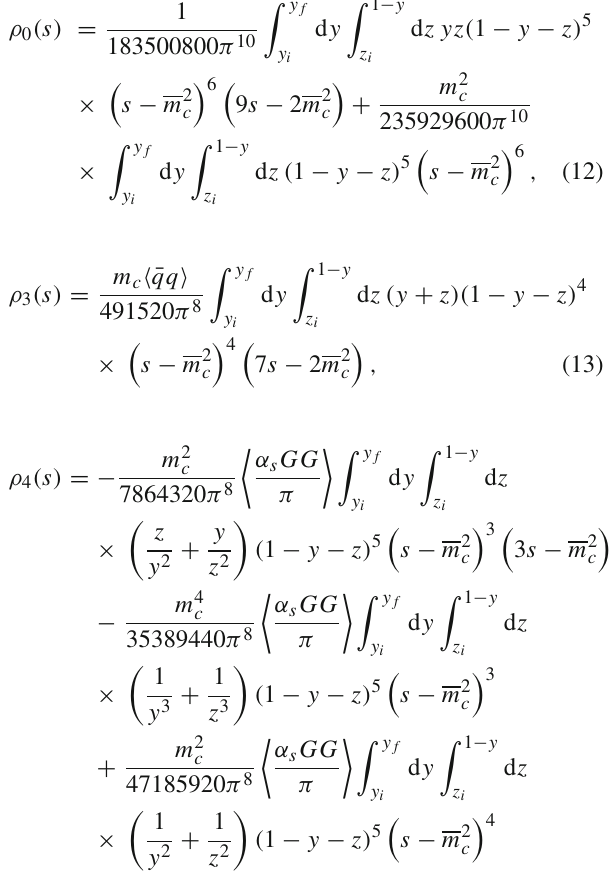
Fig. 2 The diagrams contribute to the squared mixed condensate (cid:6)¯ qg s σ Gq (cid:7) 2 from the terms (cid:6)¯ q j σ μν q i (cid:7) . Other diagrams, obtained by interchanging of the heavy quark lines (dashed lines) or light quark lines (solid lines), are